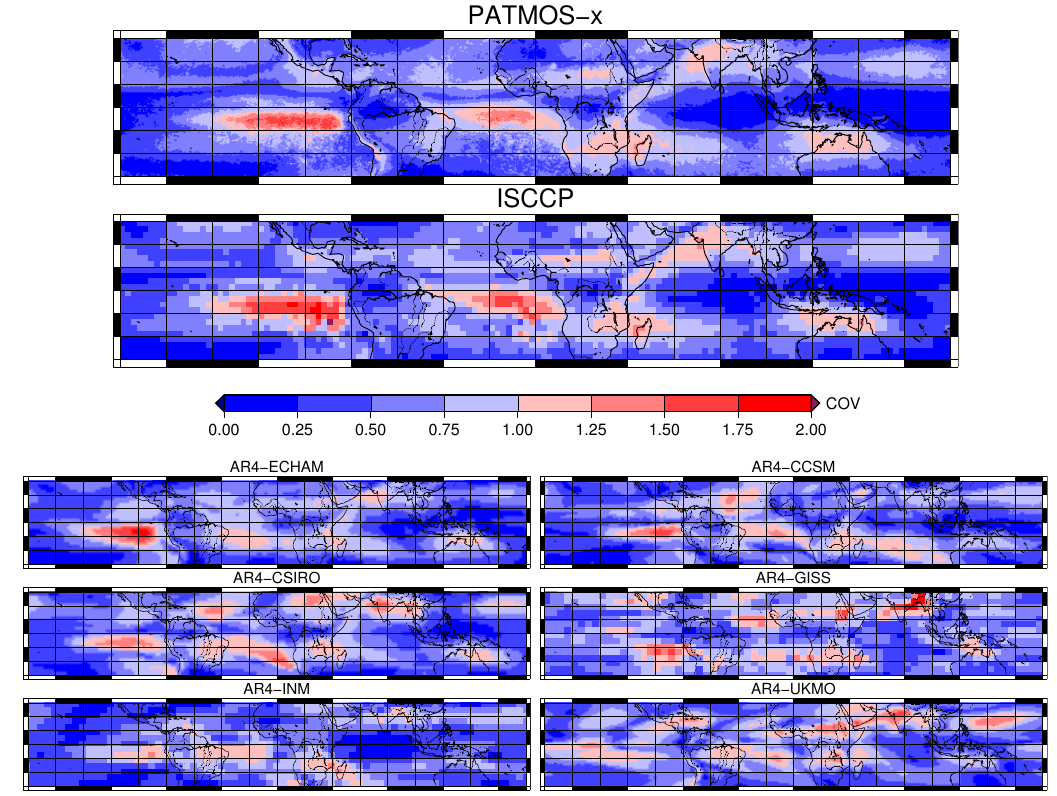
Fig. 8. Coefficient of variation, depicting the seasonal cycle of IWP in the tropics (30 ◦ S–30 ◦ N). The top two panels are the datasets, PATMOS-x and ISCCP, both of which have sufficiently long temporal ranges to capture the inter-annual variability of IWP. The bottom six panels are the subset of models used in this survey.